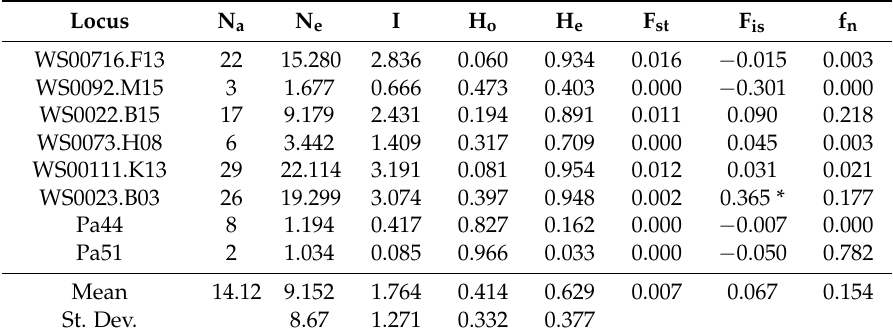
Table 3. Characteristics of EST-SSR loci across five investigated Norway spruce populations.